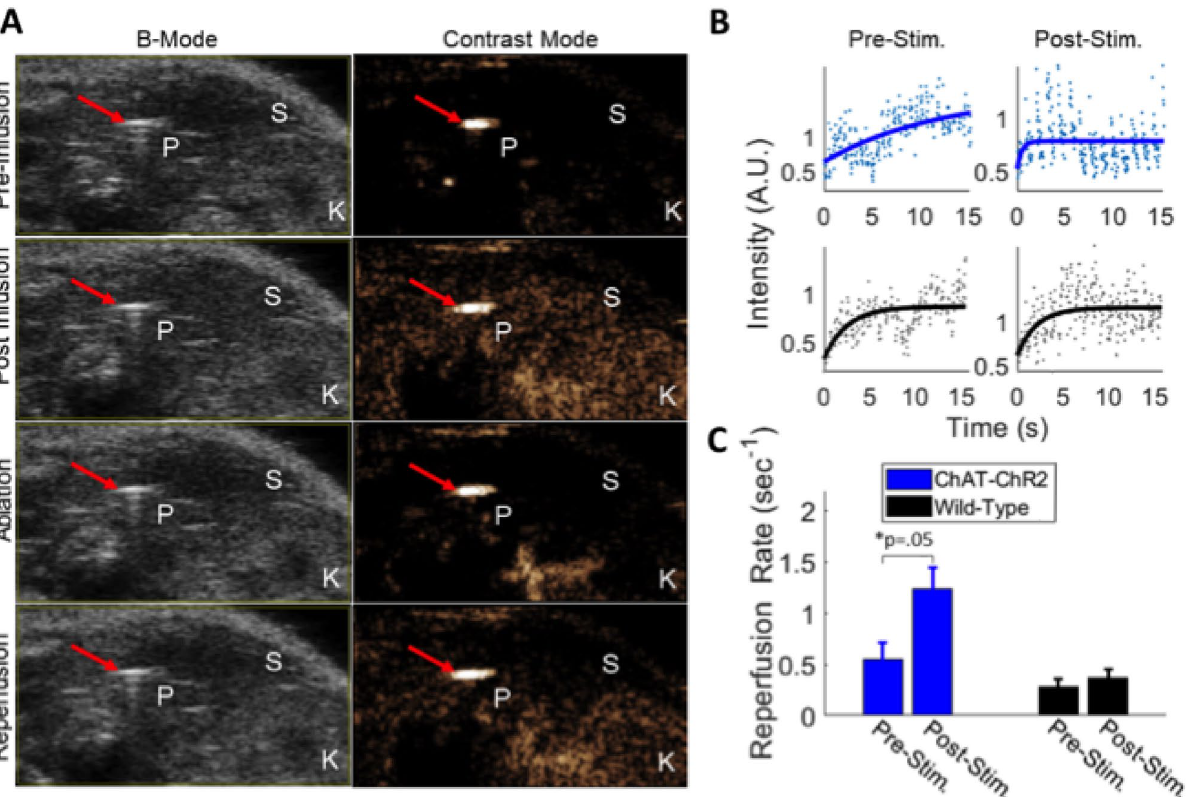
Figure 4. Measurement of pancreatic blood perfusion using contrast enhanced ultrasound imaging of microbubbles. ( A ) B-mode and sub-harmonic contrast mode images in the abdominal cavity. Microbubble- generated sub-harmonic contrast is observed in the tissues during microbubble infusion and during reperfusion following flash-destruction. Red arrow = optical cannula/needle tip, P = pancreas (tail), S = spleen, K = kidney. ( B ) Example single recording reperfusion data and curve fit before and after laser stimulation for a ChAT-ChR2 mouse and wild-type mouse. Intensity is based on microbubble (MB)-generated sub-harmonic contrast as MBs perfuse back into the pancreas following flash destruction. Curves are fitted to a single component inverse exponential to extract the rate of signal elevation (k r = 1/time constant of recovery). Upper panels (blue points and curves) are from a ChAT-ChR2 mouse and lower panels (black points and curves) are from a wild-type mouse. ( C ) Mean reperfusion rate in ChAT-ChR2 mice and wild-type mice, prior to laser stimulation and after 25 min of laser stimulation. Data in C presented as the mean over n = 8 ChaT-ChR2 recordings and n = 5 WT recordings. Error bars represent standard error in the